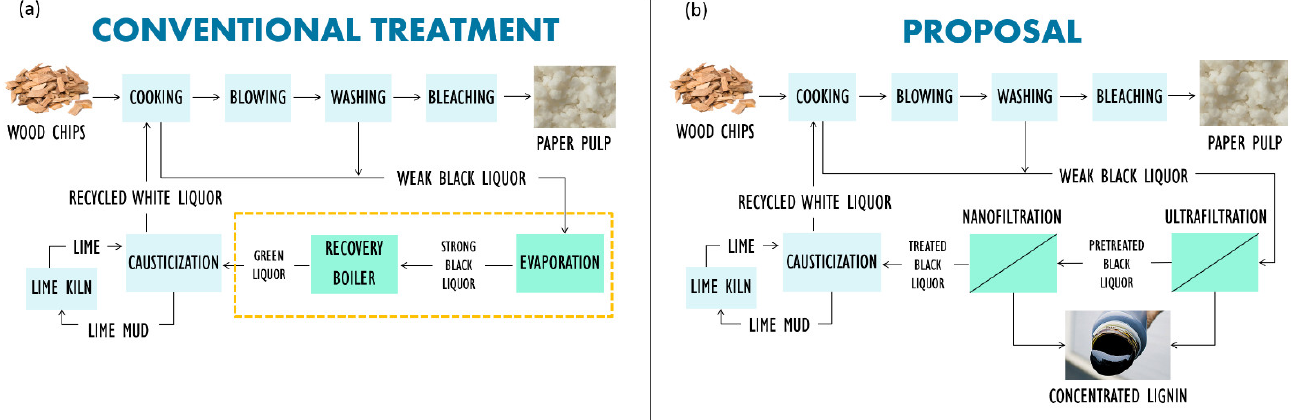
Figure 1. Scenario 1, conventional treatment of black liquor using evaporators ( a ) and recovery boilers and Scenario 2, Proposal of this study using membrane technologies ( b ).